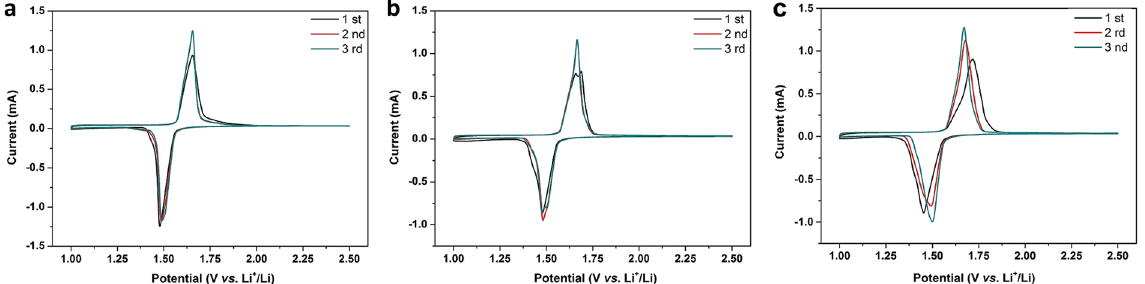
Figure 5. Cyclic voltammograms of ( a ) pure LTO, ( b ) LTO-RT and ( c ) LTO-RT-AT.